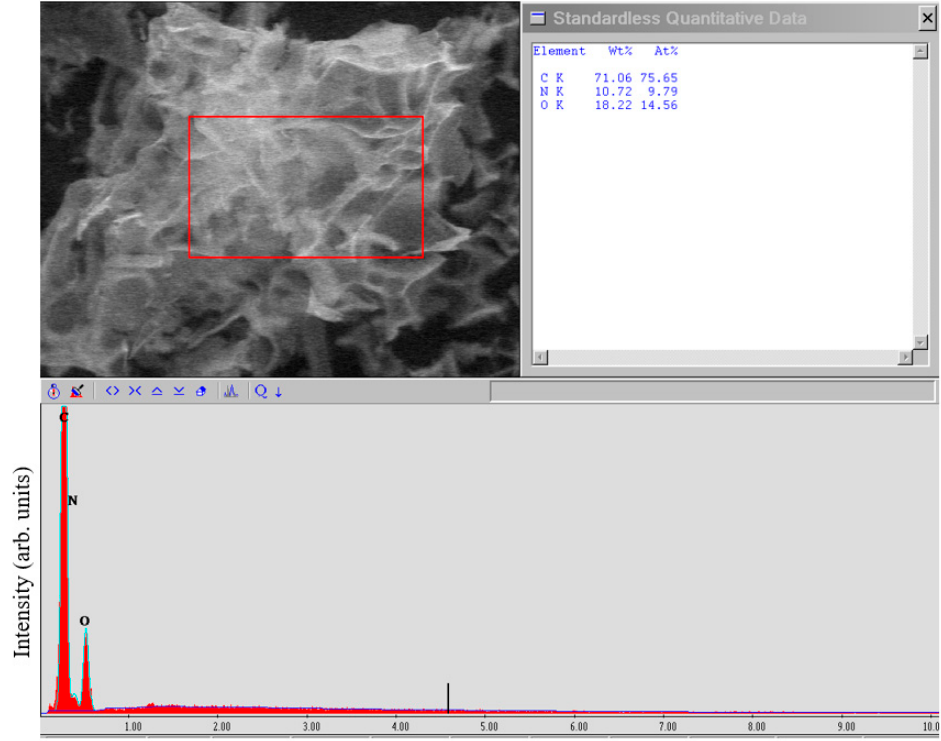
Figure 4. EDX study of synthesized FLG nanosheets from glucose. In bottom picture Y axis—Intensity of EDX signal, arb.units, X axis—electron energy, keV.